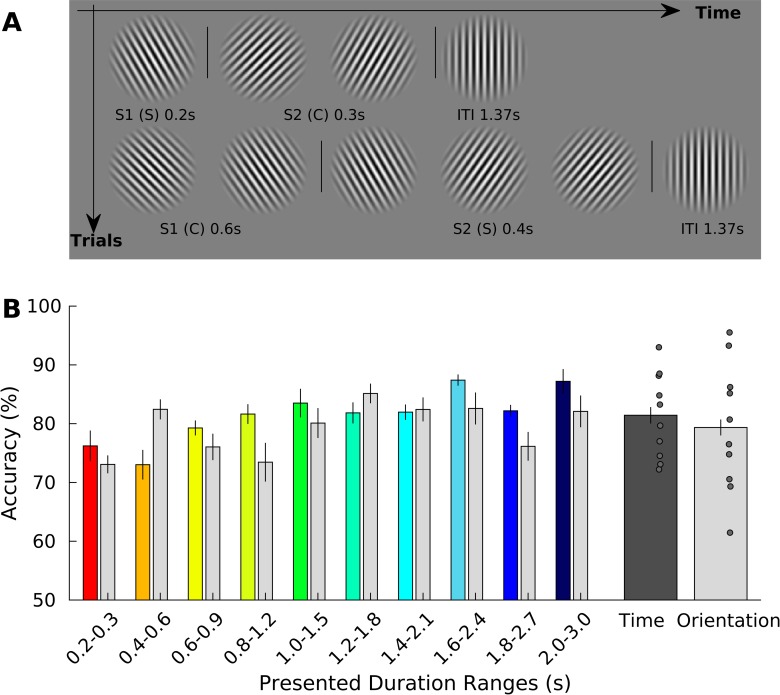
Stimulus sequence and behavioral results of Exp 2.(A) Schematic representation of the stimulus sequence in a trial (Exp 2). Within a trial, the sequence of orientation changes was fixed and was always leftward first, rightward second, and vertical last. Within the two “main orientations” (left and right), the grating continuously changed its orientation at a rate of 5 Hz, and the range of changes was between 30° and 45°. Participants were asked to discriminate which of the two “main orientations” (leftward or rightward) was displayed for longer time (time task) or to judge which one of them underwent the biggest change (orientation task). S is standard and C the comparison duration. There were 10 standard durations, ranging from 0.2 to 2 s, in step of 0.2 s. The presentation order of S and C was randomized and counterbalanced across trials. In half of the trials, S1 was a standard; in the other half, it was a comparison duration. The comparison duration was 50% of the standard. The vertical orientation signaled the time to make the response (by pressing one of two response keys on a keypad), and it was also the intertrial interval (1.37 s). (B) Average percentage of accuracy (N = 10) in the time and orientation task plotted separately for each of the 10 pairs of durations and as a mean of them (rightmost plot for time and orientation task). The data can be found in S1 Data. Error bars represent standard errors. Gray dots are different subjects. C, comparison duration; S, standard duration; S1, first stimulus.